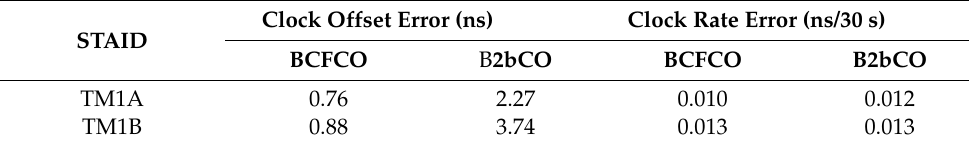
Table 5. Statistical results of timing performance of TM1A and TM1B.